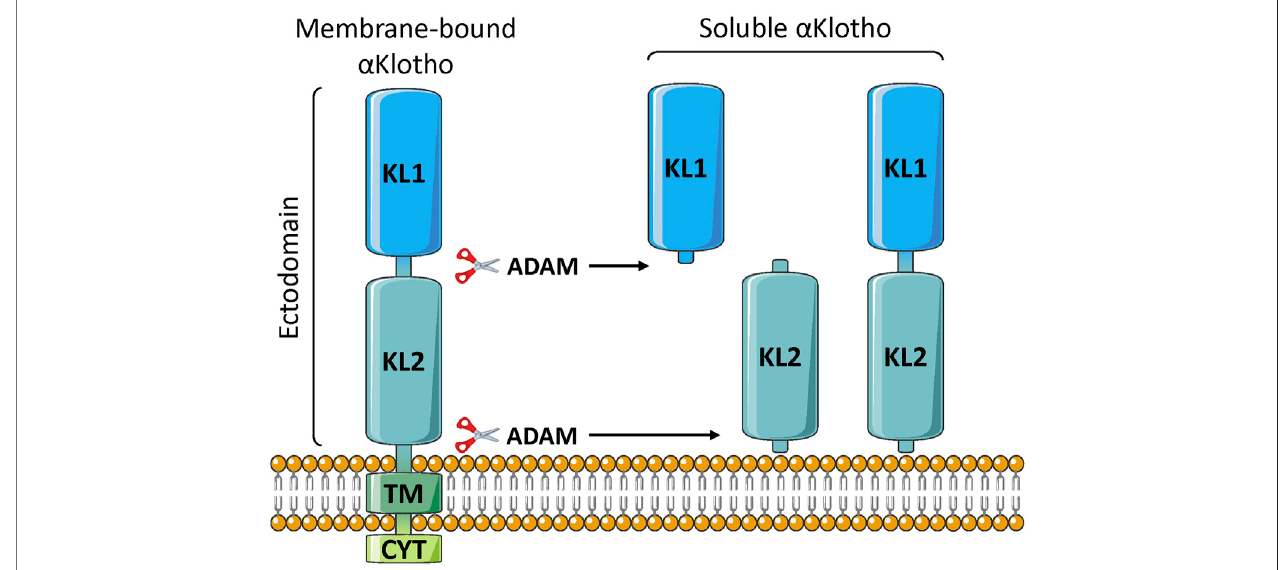
FIGURE1| Klothostructure.Themembrane-boundformissingle-pass,andconsistsoftwoextracellulardomains(KL1andKL2),atransmembranesegment(TM), and a short non-signaling cytoplasmic tail (CYT). The soluble form is generated by proteolytic cleavage, usually by either ADAM10 or ADAM17 enzymes, to release the largesolubleform(s-Klotho).Thisisthemajorformfoundinthecirculation.ItcanbefurthercleavedtogenerateindependentKL1andKL2fragments,buttheseareeither minor forms or undetectable in the plasma.